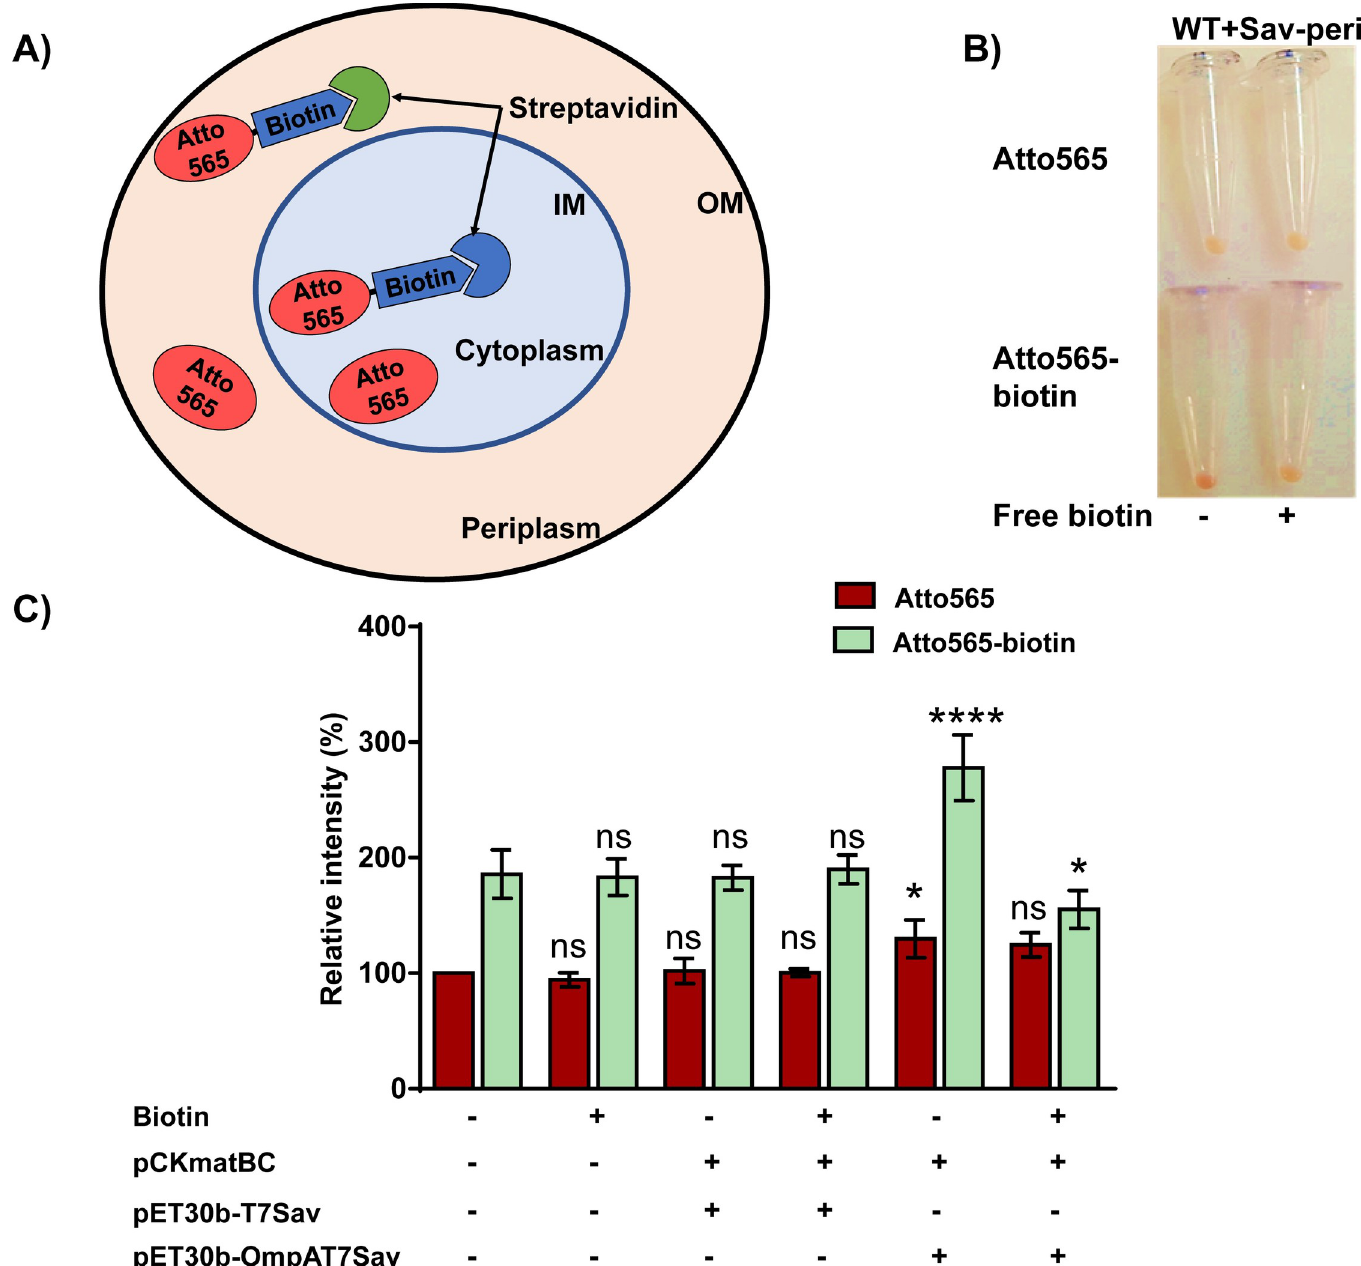
Fig 3. Accumulation of Atto565 and Atto565-biotin in E . coli expressing streptavidin either in the periplasm or cytoplasm. A) Schematics showing plasmid-expressed streptavidin binds to Atto565-biotin. B) Image of cell pellets showing redder color (higher accumulation) of Atto565-biotin in cells expressing periplasmic streptavidin and decrease in the accumulation in the presence of free biotin. C) Quantitative analyses of accumulation of Atto565 and Atto565-biotin in cells expressing streptavidin in the presence or absence of free biotin. Figure shows the representative data from three independent experiments. Data were presented as mean ± S.D. (Two-way analysis of variance; ���� p < 0.0001, � p < 0.05). Asterisks above the Atto565 accumulation bar represent significance when compared them with Atto565 accumulation in WT strain, whereas asterisk above the Atto565-biotin accumulation bar represent the significance when compared with Atto565-biotin accumulation in WT strain. lacking major efflux systems. We used BW25113 and its isogenic Δ acrB and Δ tolC strains. Deletion of the acrB gene did not have a significant effect on accumulation of both com- pounds. A higher accumulation for both compounds were observed in the Δ tolC strain than in